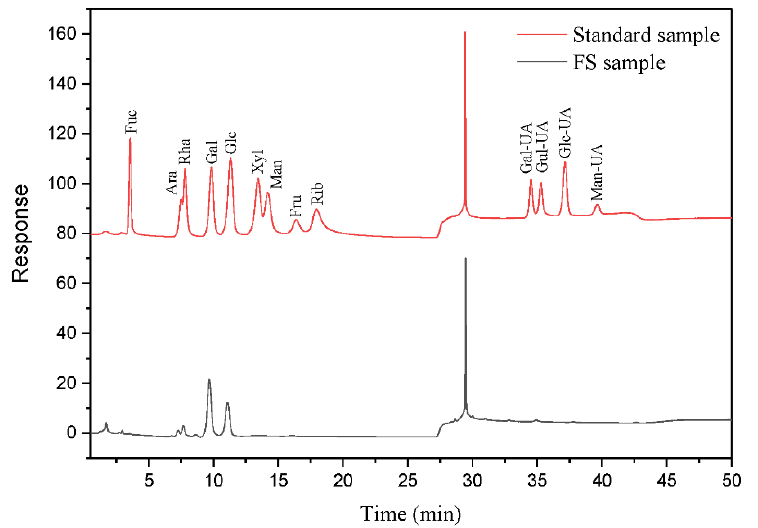
Figure 8. Monosaccharide ion chromatogram of polysaccharide: the red line represents mixed monosaccharides standard, and the black line represents the FS sample.